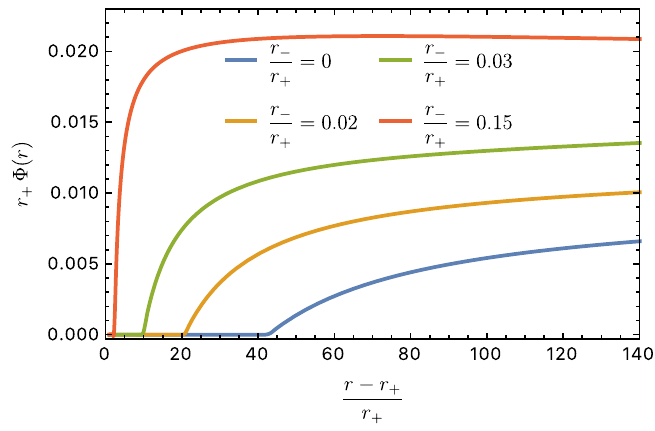
Figure 3 . Pro(cid:12)le of the background (cid:12)eld (cid:8) as a function of the radius r . Speci(cid:12)cally, it is plotted r + (cid:8)( r ) in terms of r (cid:0) r + for (cid:21) = 7 : 1 (cid:2) 10 (cid:0) 3 , r + (cid:22) = 0 : 01 for several values of r (cid:0) , namely r + r + r (cid:0) = 0 ; 0 : 02 ; 0 : 03 ; 0 : 15. The case r (cid:0) = 0 is the Schwarzschild case and r (cid:0) = 0 : 02 ; 0 : 03 ; 0 : 15 are r + r + r + typical Reissner-Nordstr(cid:127)om cases. The extremal case r (cid:0) = 1, not shown, starts from (cid:8) = 0 at r + r = r + and jumps immediately to a (cid:12)nite value in a step function as can be inferred from the plots, i.e., there is no bubble for extremal black holes.